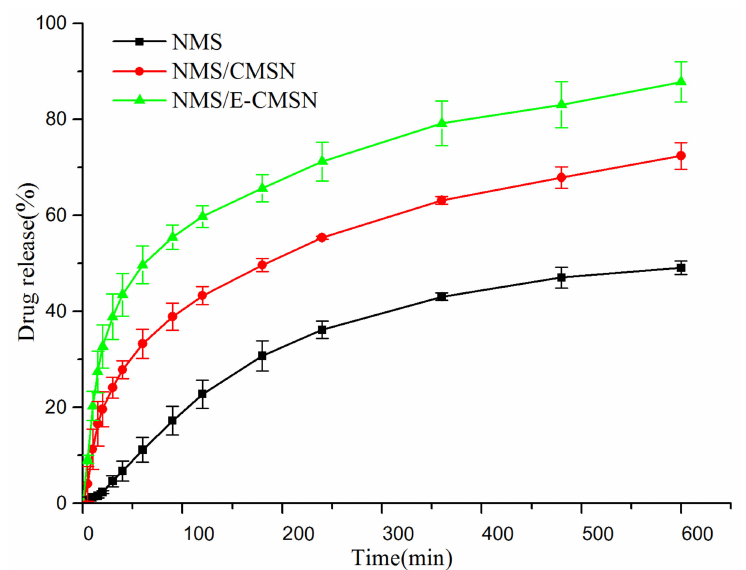
Figure 7. In vitro release profiles of NMS, NMS / CMSN, and NMS / E-CMSN in pH 6.8 PBS at 37 ◦